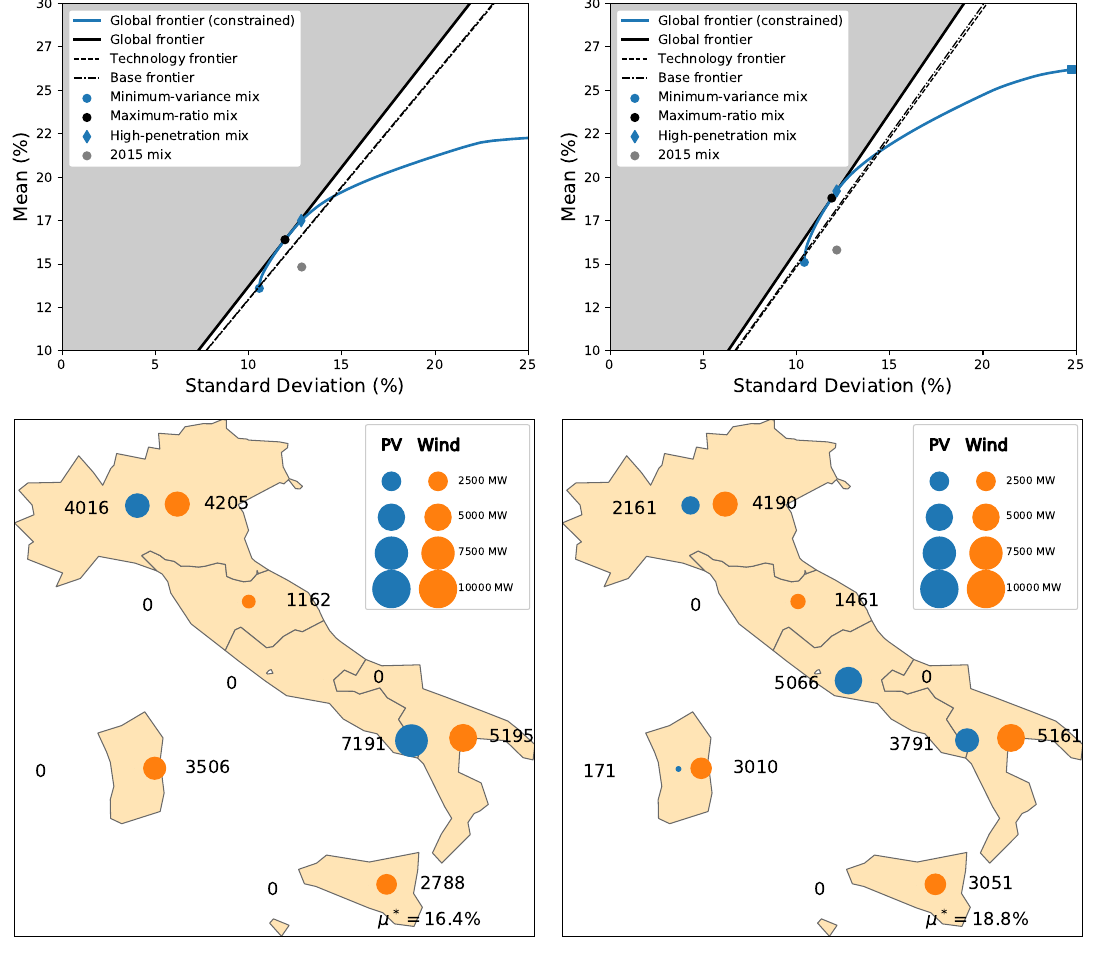
Figure 8. Optimal frontiers approximations (up) and PV-wind capacity distributions (down) for the global optimization problem obtained from the CORDEX hourly data over the years 1989 (left) and 1996 (right). To be compared with Figures 4a and